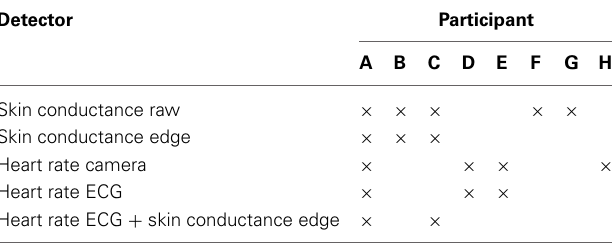
Table 2 | Participants without detected stress response for at least one